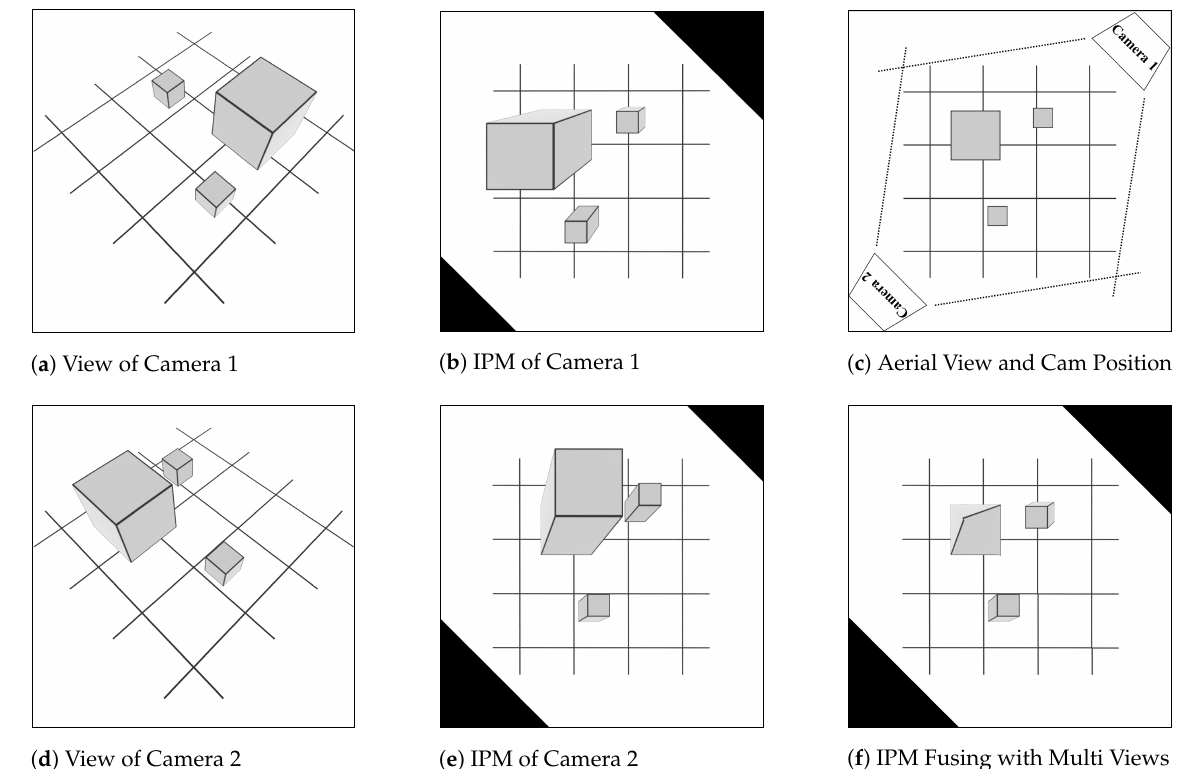
Figure 2. Overview of the parking lot coordinate mapping framework. In order to obtain an aerial view using images from cameras 1 and 2 ( a , d ), IPM needs to be called. After the processing of IPM, ( b , e ) can be obtained. Finally, the fused aerial view image by fusing ( b , e ) is shown in ( f